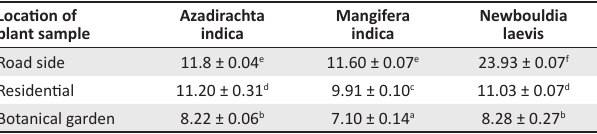
TABLE 1: Lead concentration (ppm) in selected medicinal plants across locations within the University of Ibadan. Location of plant